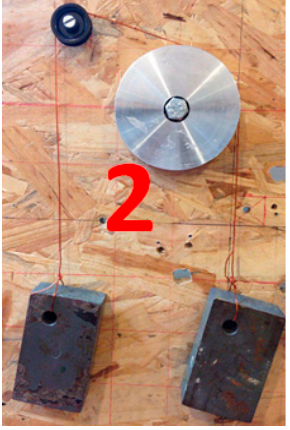
Figure 11. Assembly with occupancy of the quarter disc. Table 2. Capacitance for different wire lengths. Assembly No.